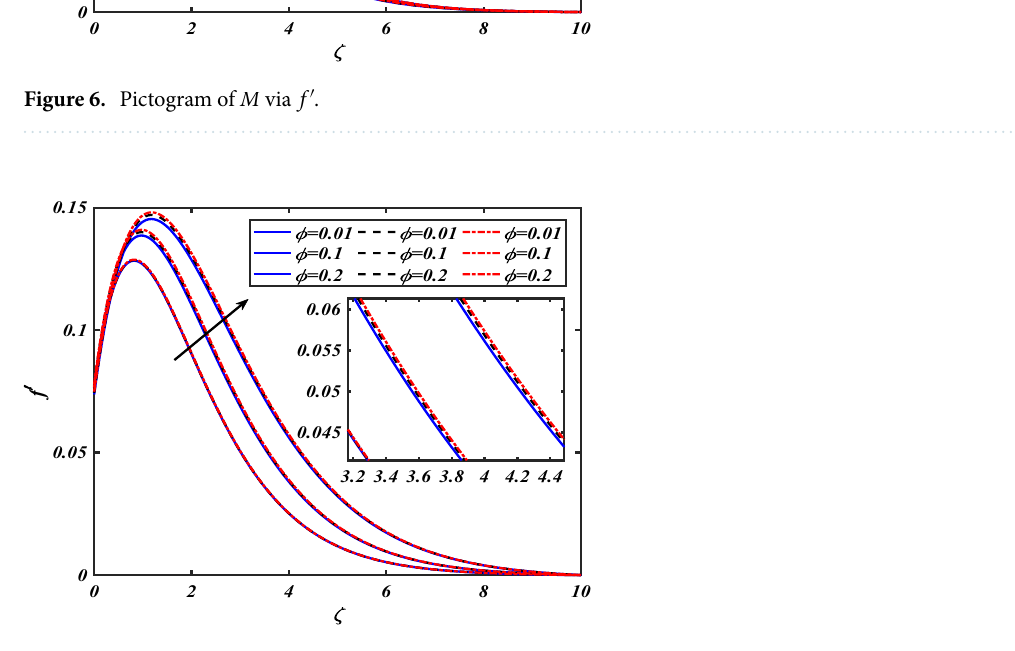
Figure 7. Pictogram of φ via f ′